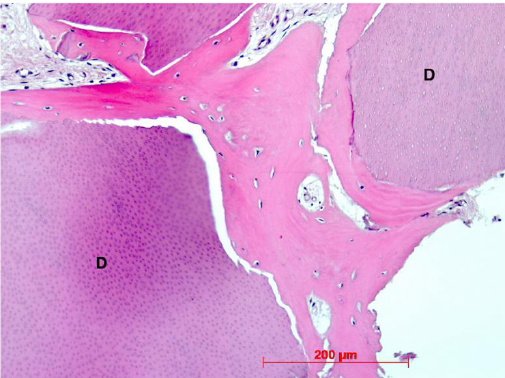
Figure 11. Patient 5 — Early-stage osteogenesis around dentin granule (D), HE, original magnifica- tion ×20.